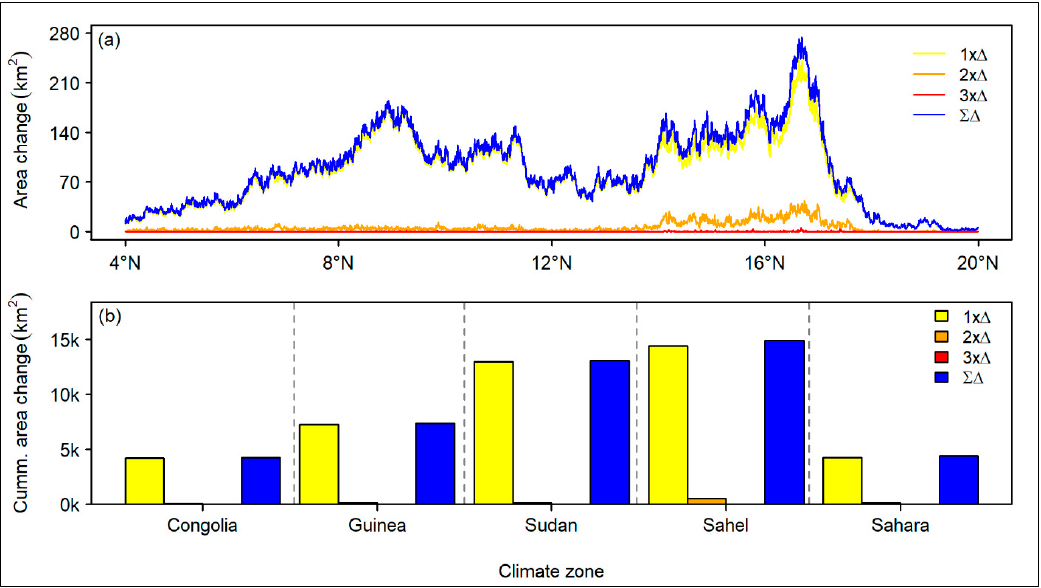
Figure 4. Land cover change area variation in West Africa categorized by ( a ) change frequency from 4 ° N to 20 ° N ( b ) cumulative change frequency per climatic zone.